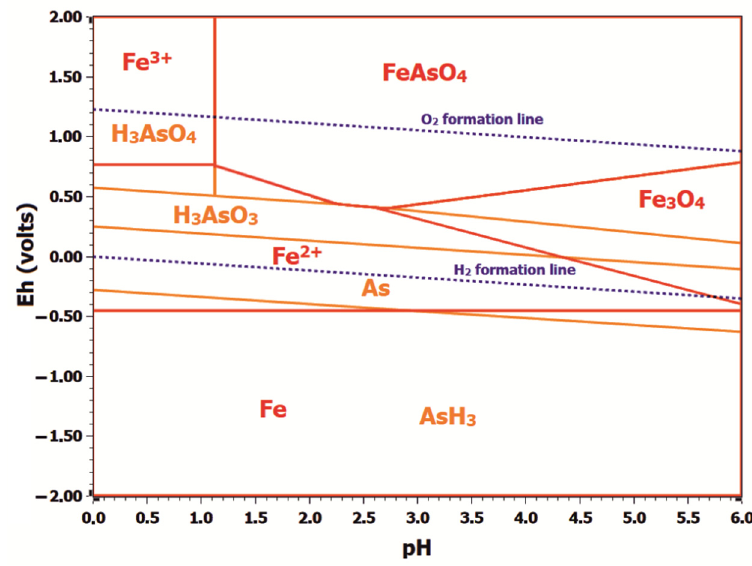
Figure 3. Pourbaix diagram of As-Fe-H 2 O system.